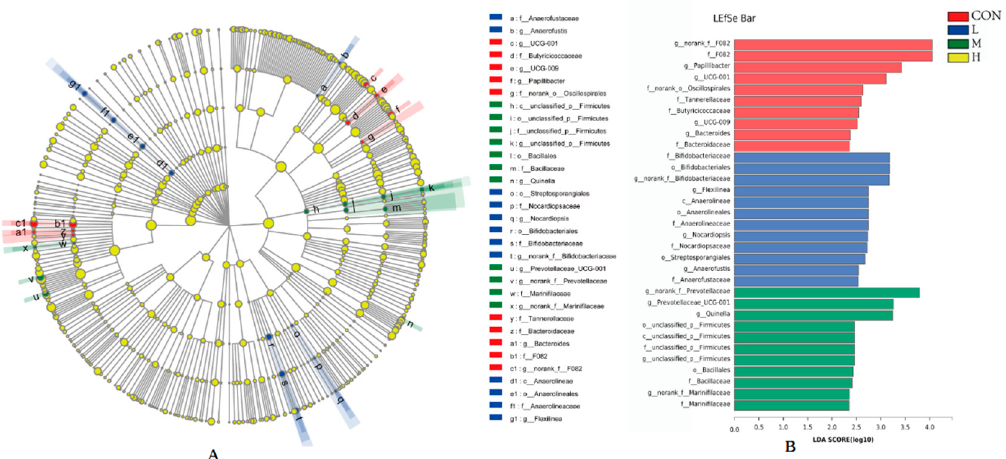
Figure 4. Bacteria differentiated between samples, different groups identified by linear discriminant analysis ( A ). Green, red and blue bars or nodes represent the bacteria with the significantly higher relative abundance in CON, L and M groups, respectively. LDA analysis of rumen microbial abundance ( B ). The larger the LDA score, the greater the influence of species abundance on the difference effect.